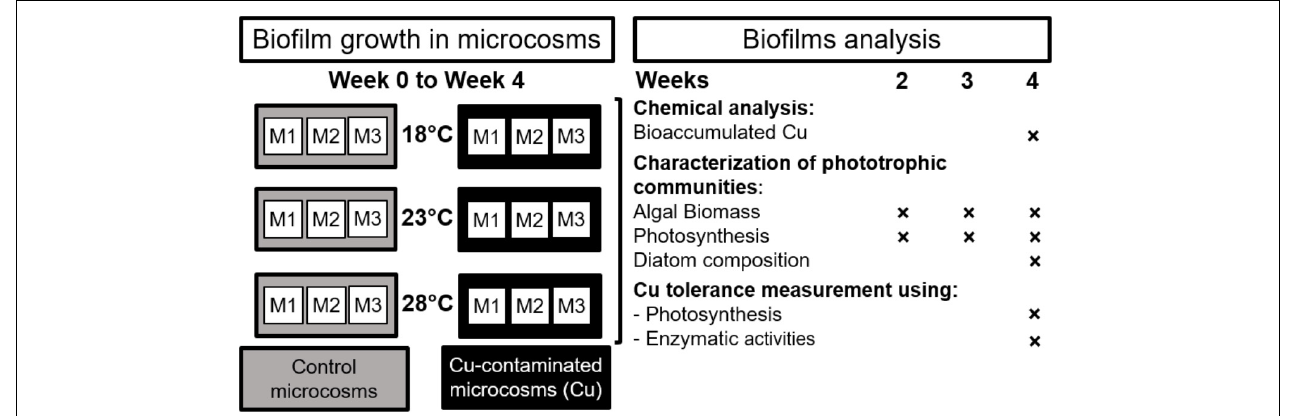
FIGURE 1 | Microcosm experimental design and analytical strategy. M: Independent microcosm .